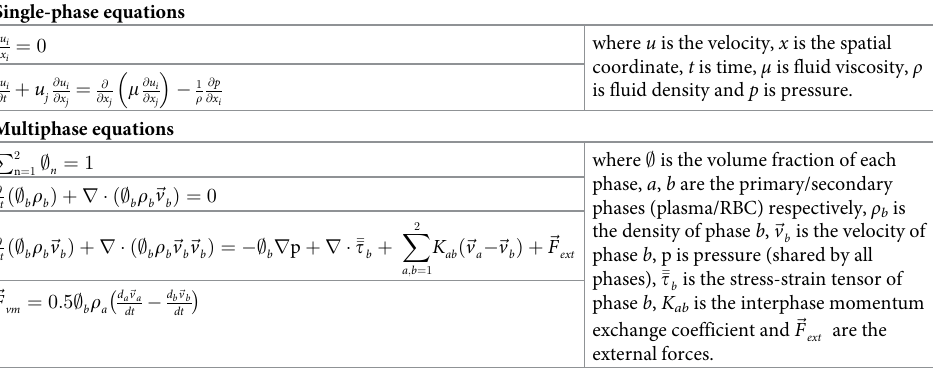
Table 2. Conservation of mass and momentum for the single and multiphase models, with the volume fraction and external force (virtual mass) definitions for the multiphase models. Single-phase